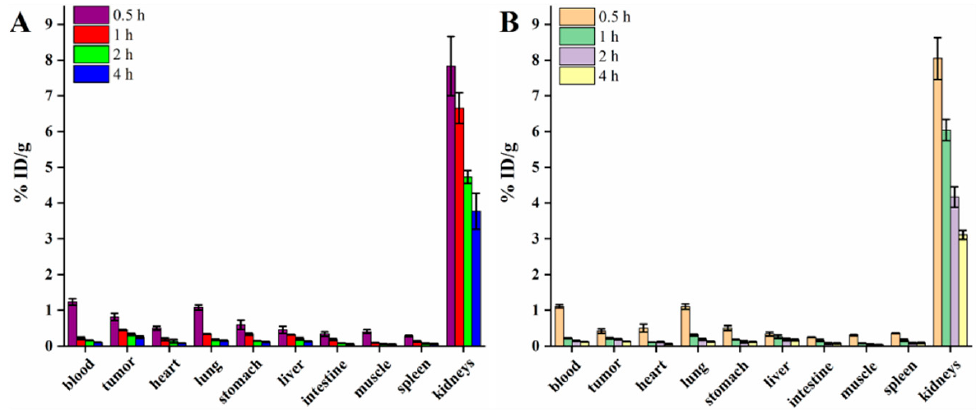
Figure 7. Biodistribution of [ 99m Tc]Tc-HYNIC-PTP in ( A ) 4T1 and ( B ) C6 tumor-bearing mice at different time points.